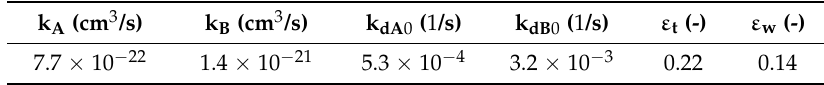
Table 3. The optimal values of k A , k B , k dA0 and k dB0 with the smallest sum of ε t and ε w for 1.86 ≤ S A ≤ 3.4 at 35 ◦